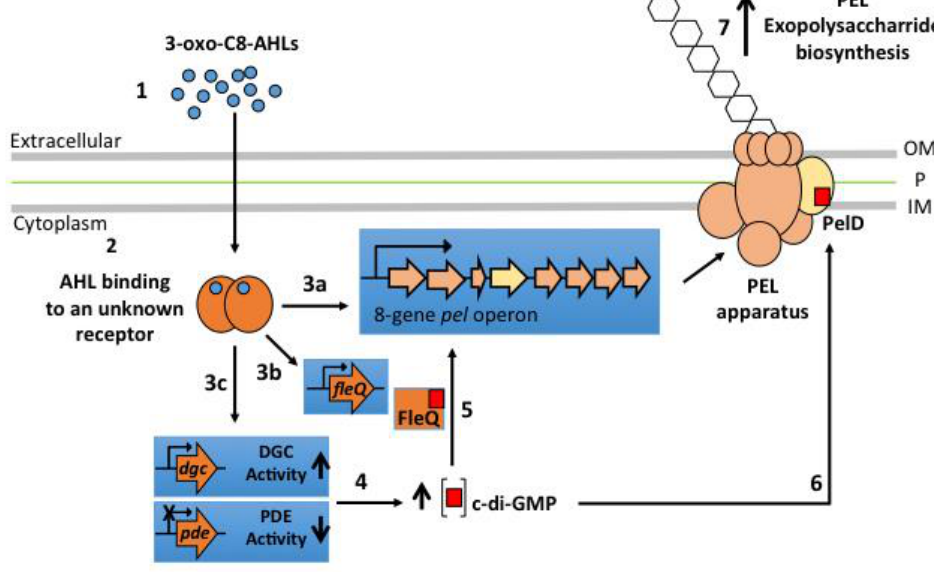
Figure 5. Working model for the regulation of PEL exopolysaccharide biosynthesis by obligate sulfur-oxidizing Acidithiobacillus species based on experimental data previously reported and obtained here with A. thiooxidans . The binding of 3-oxo-C8-AHL (1) by an unknown AHL receptor that could act as a positive transcriptional regulator (2) can directly promote pel operon expression (3a; Figure 3). But it may also induce the transcription of FleQ (3b) and diguanilate cyclase (DGC) (3c) encoding genes and/or repress the transcription of phosphodiesterases (PDE) encoding genes (3c). The new balance between DGC and PDE activities generate an increase of intracellular c-di-GMP levels (4). Then, c-di-GMP can bind to its specific receptors FleQ (5) and/or PelD (6) promoting the biosynthesis of PEL exopolysaccharide (7). OM, Outer membrane; P, Peptidoglycan; IM, Inner membrane.